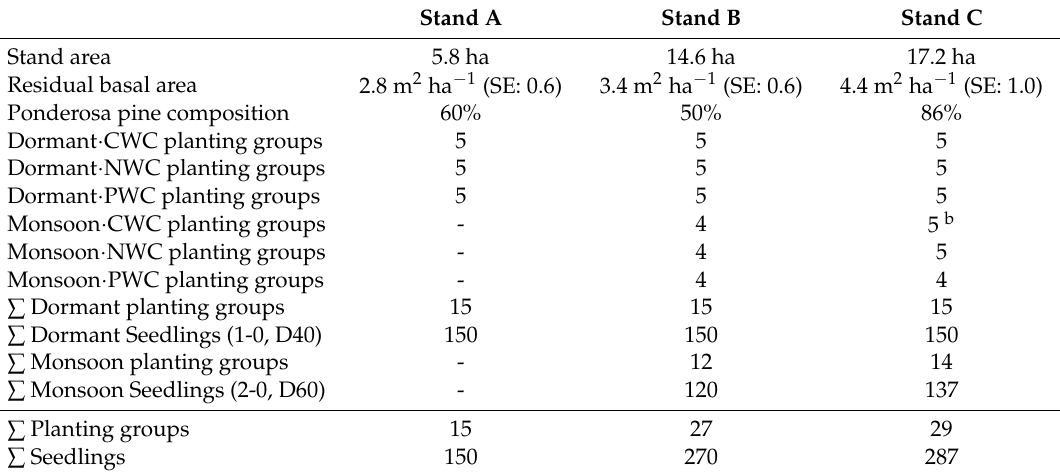
Table 1. Overview of Davis Mountains Preserve study stands and their condition at the time of planting, number of ten-tree planting groups for planting season · vegetation management a treatment combination in each stand, and total number of seedlings c planted for each treatment combination in each stand. SE refers to standard